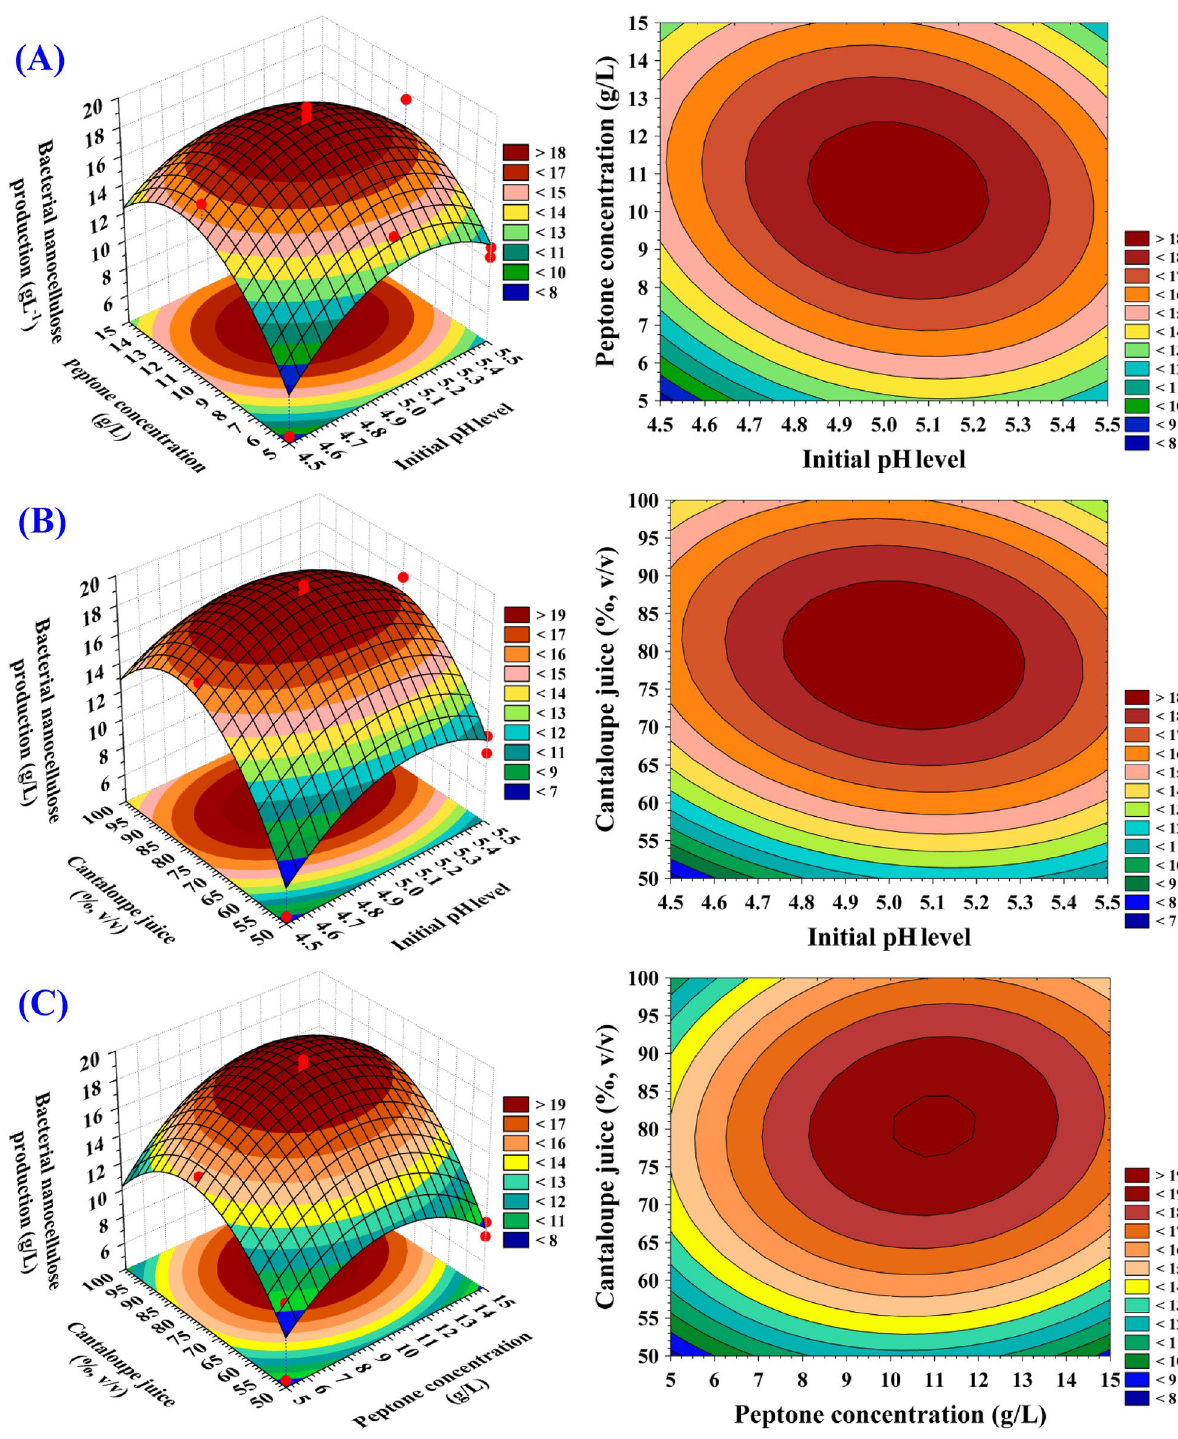
Figure 8. ( A – C) 3D plots showing the mutual effects of pH (X 1 ), peptone concentration (X 2 ) and Cantaloupe juice